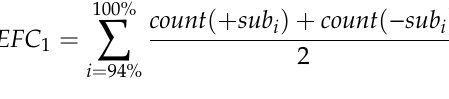
Figure 9. Recurrences of SOC’s substrings for ( a ) 3 min; ( b ) 15 min; ( c ) 30 min; and ( d ) 60 min temporal resolution.